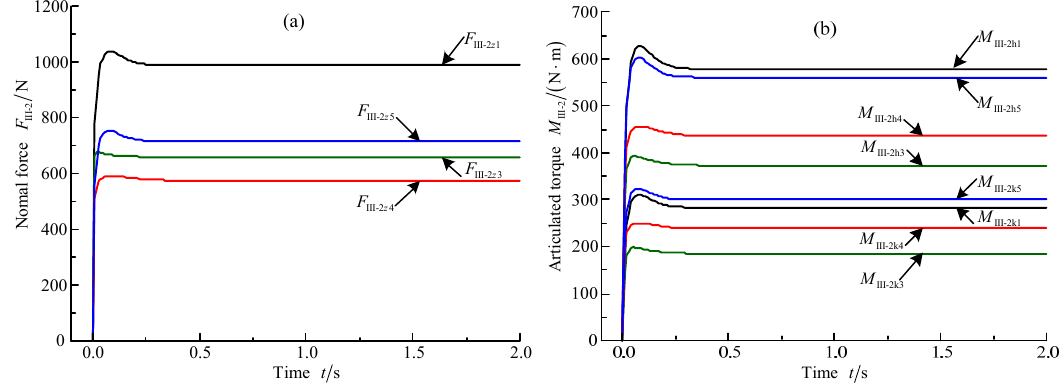
Figure 24. Simulation curves: ( a ) normal forces of support phase; and ( b ) static torques of hip joints and knee joints in support phase.